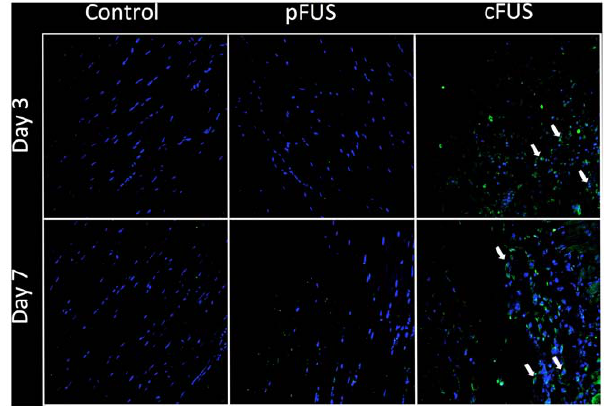
Figure 6. Effect of FUS on apoptosis. Blue represents DAPI-stained nuclei and green represents TUNEL-positive nuclei. No apoptotic nuclei were observed on days 3 or 8 following pFUS or in untreated control muscle at the same time points. However, several apoptotic nuclei were observed near the margin of the cFUS treatment volume on both days 3 and 8